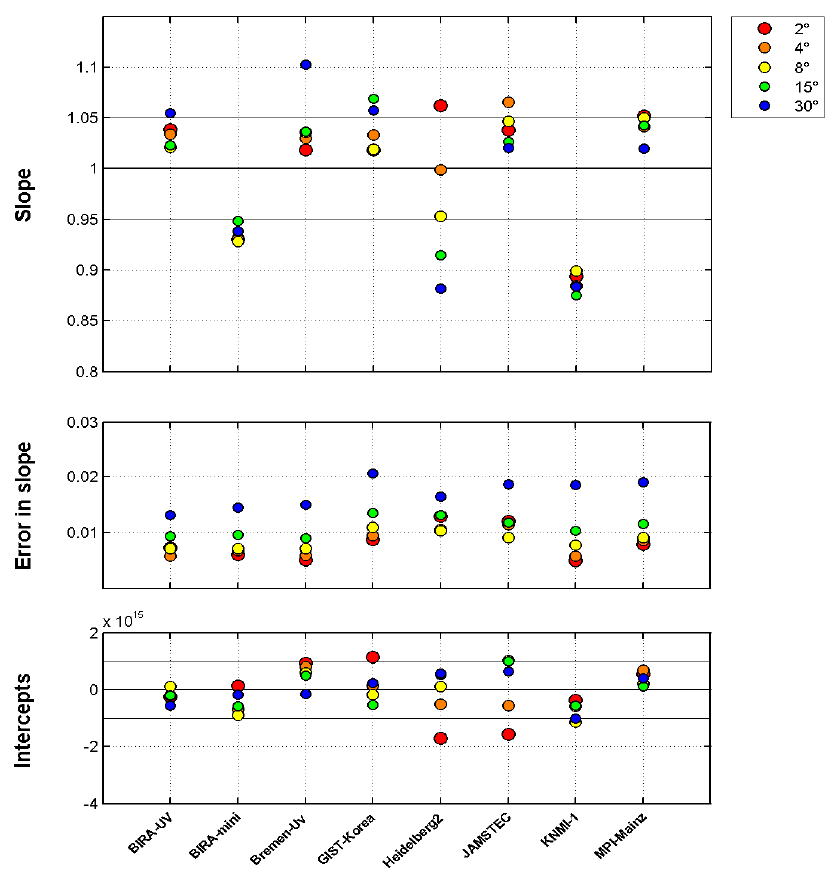
Fig. 10. Straight-line slopes and their errors of NO 2 slant columns against those of the reference data set, for each instrument at UV wavelengths and for the whole campaign. Colours refer to elevation angles shown top right.